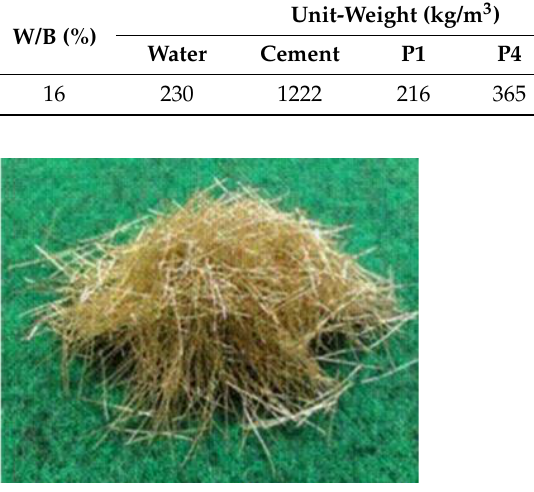
Figure 2. Steel fibres